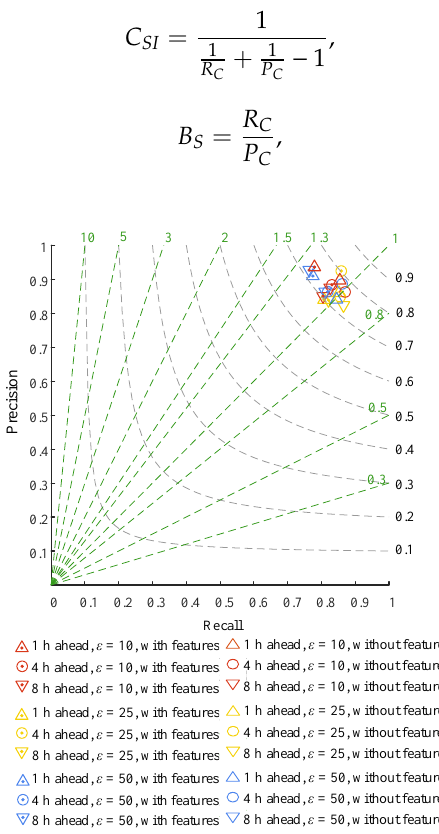
Figure 10. Forecast model performance with different parameters.